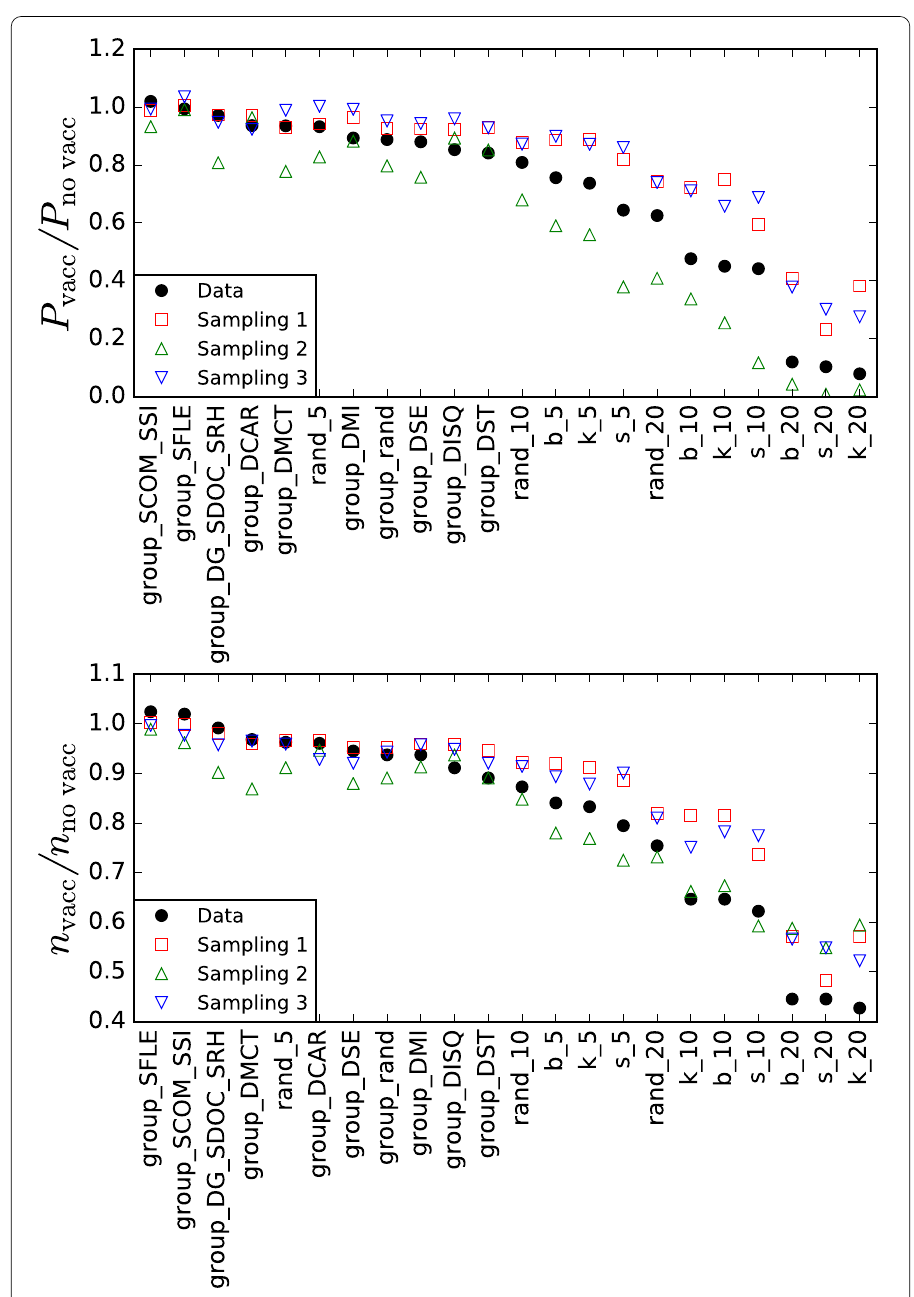
Figure 9 Vaccination strategies. InVS15 data set. We plot the ratio between the vaccination and no vaccination cases of the fraction of the total number of outbreaks that reach at least 20% of the population (top), and of the median size of these outbreaks (bottom) for different vaccination strategies, for the original data and the reconstructed networks. The vaccination strategies are ordered by decreasing efficiency, based on the effect on the real contact data. The group_* strategies consist in vaccinating one or several groups entirely; the group_rand strategy vaccinates n g random nodes, where n g is the average group size; the rand_n strategies randomly vaccinates a specified fraction n of nodes; the b_n , k_n , s_n strategies vaccinate the top n % nodes according to, respectively, betweenness centrality, degree and strength